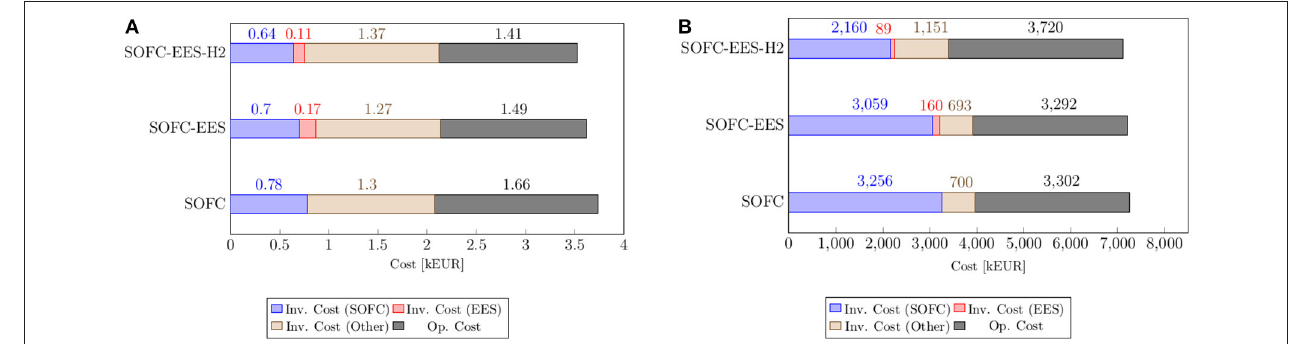
FIGURE 11 | Comparison between the proposed system and alternative SOFC-based systems. (A) Off-grid dwelling case and, (B) Cruise ship case.